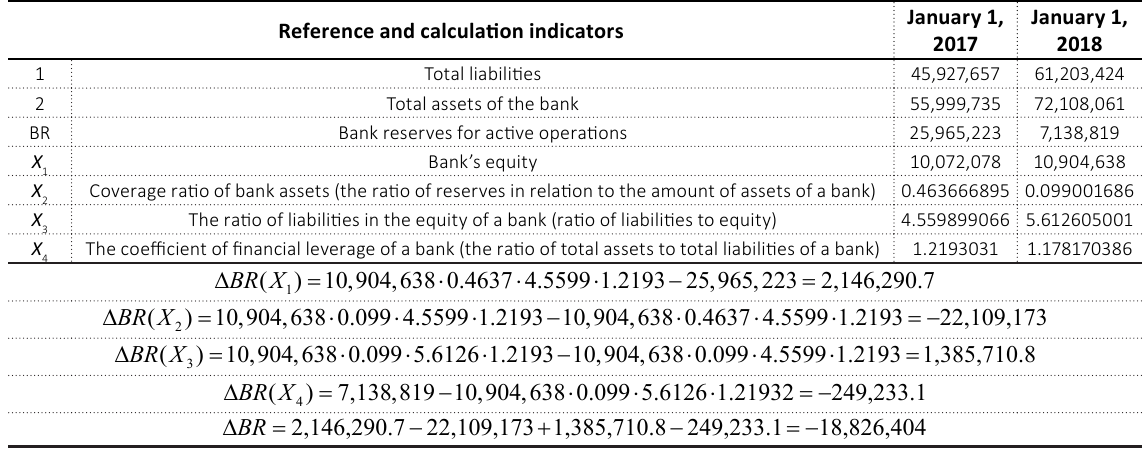
Table 7. Factor analysis of reserves for active operations of Raiffeisen Bank